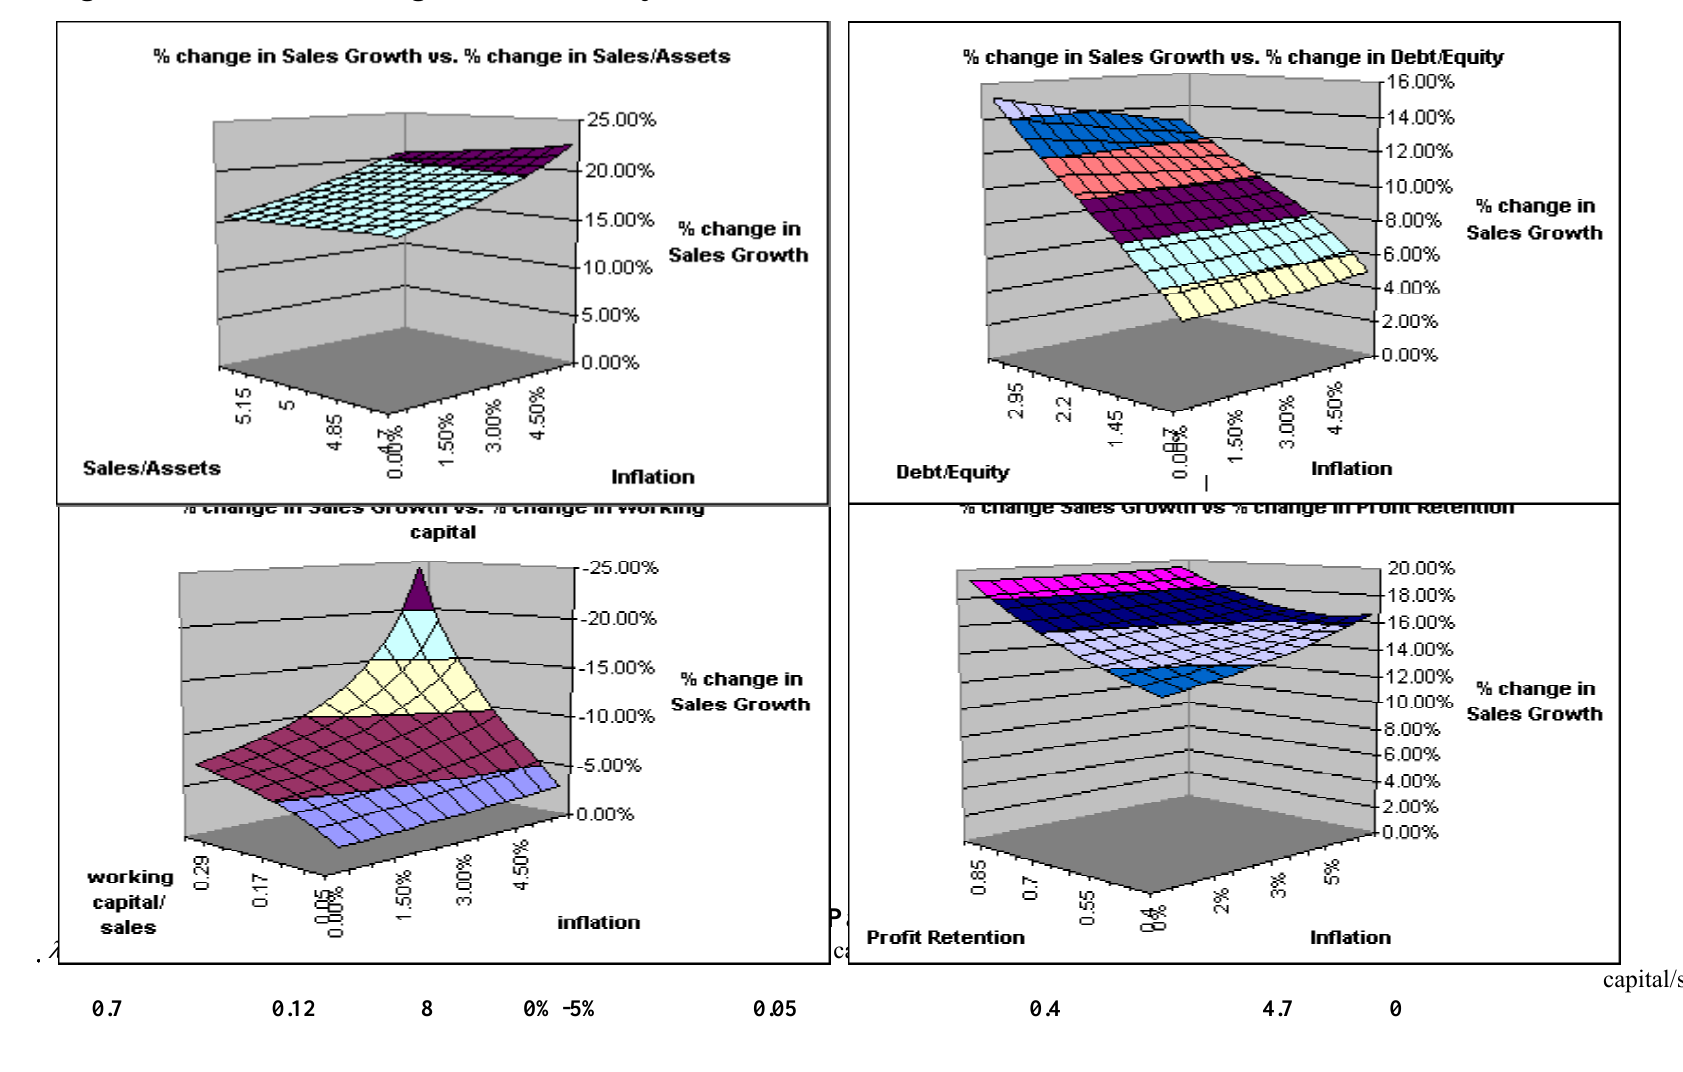
Sustainable growth